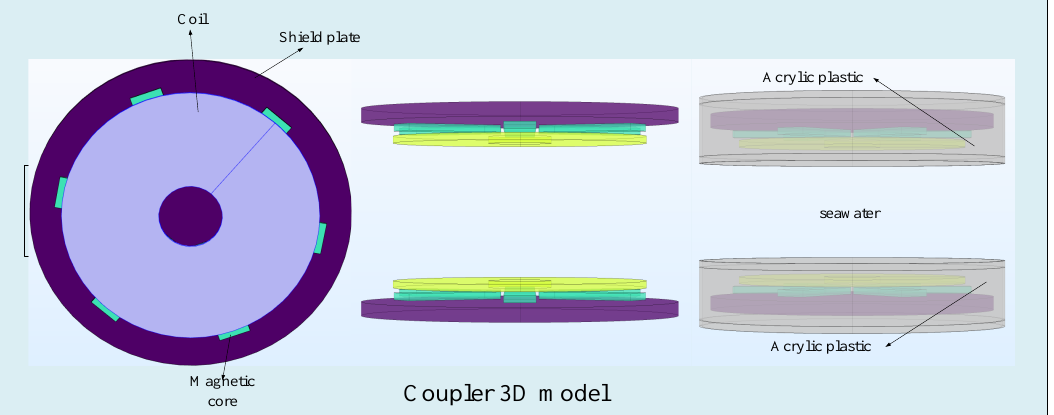
Figure 4. Coupler 3D model .